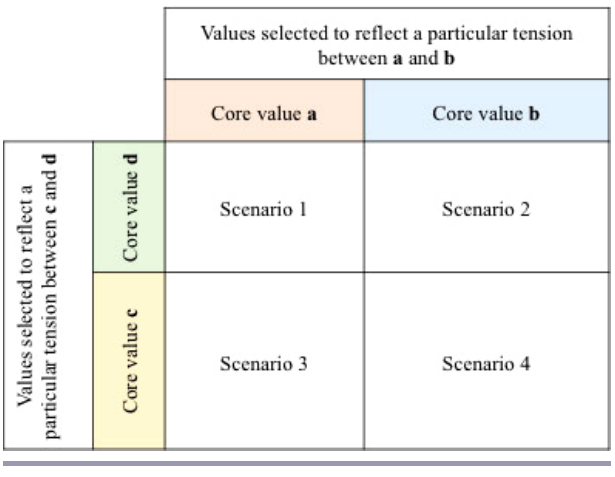
Fig. 2 . Value-based scenario planning framework based on the arrangement of contrasting values. The general framework enables those applying it to draw on different forms of abstract